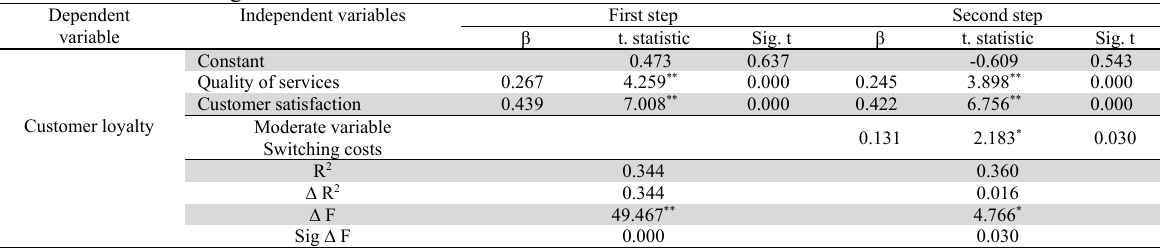
Results of hierarchical regression Dependent variable